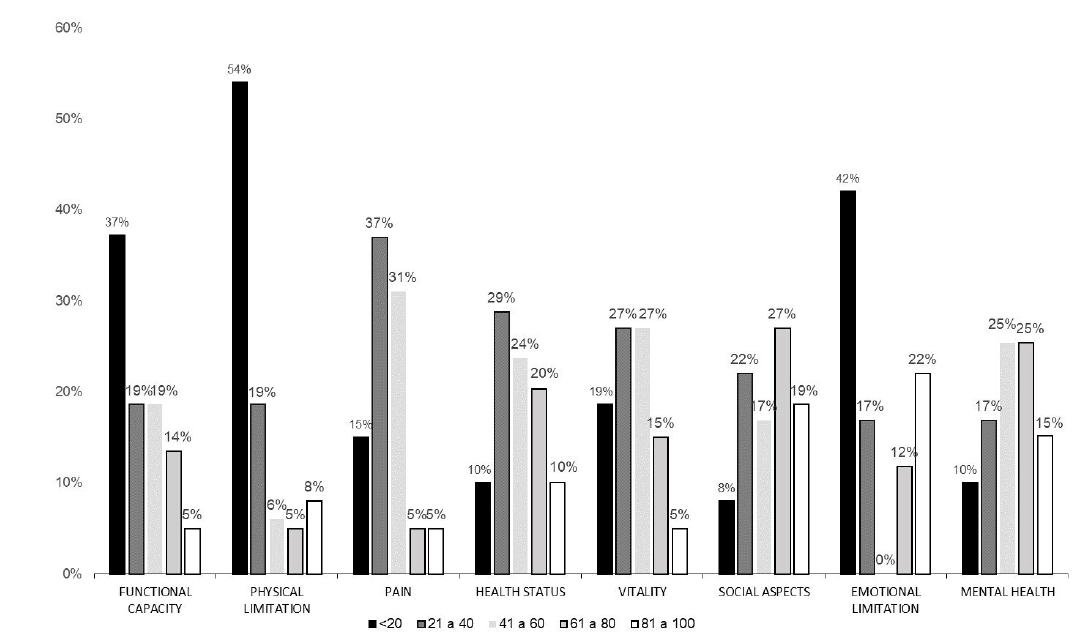
FIGURE 2 - Frequency of the results of the SF-36 questionnaire domains.